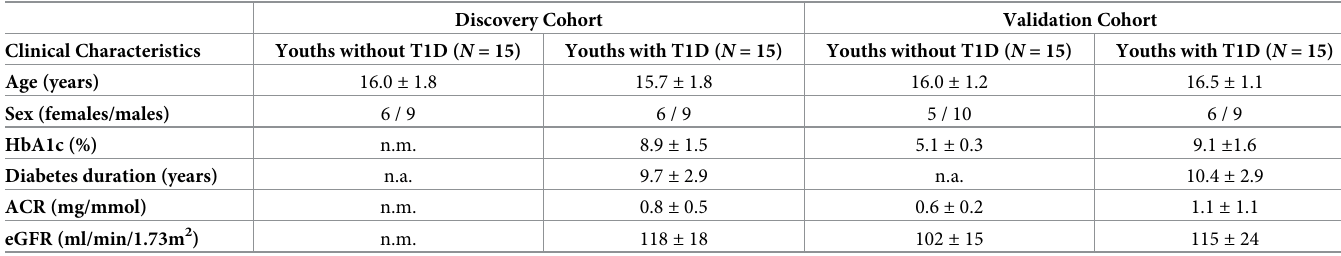
Table 1. Clinical characteristics of both cohorts at time of urine